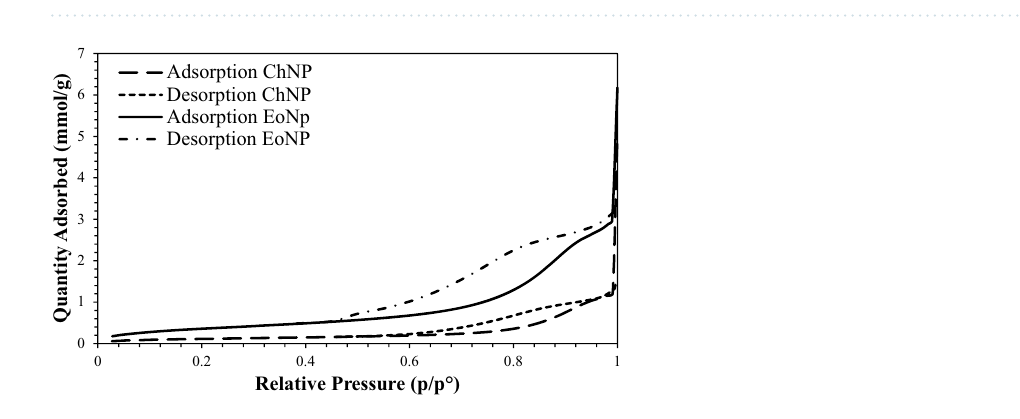
Figure 4. XRD patterns of chitosan, chitosan nanoparticles and H . pineodora essential oil loaded chitosan nanoparticles.